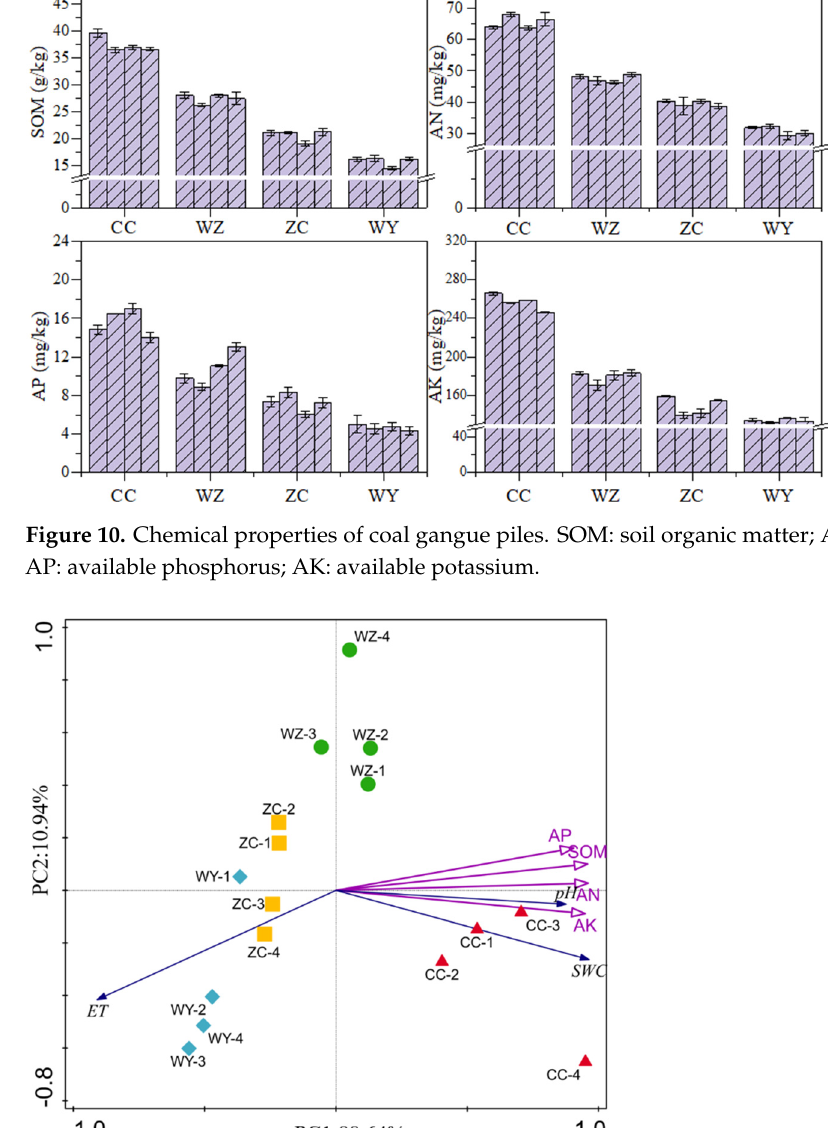
Table 3. Pearson’s correlations between the vegetation community structure and environmental factors.